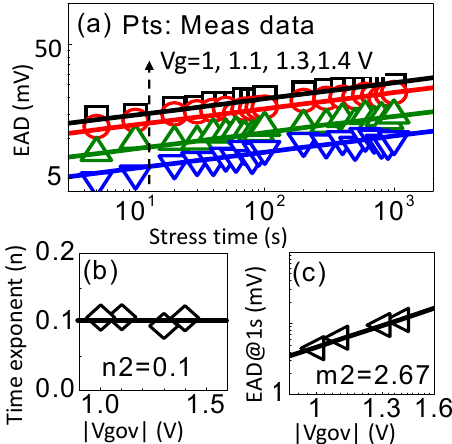
Figure 19. ( a ) The kinetics of an EAD follows the power law; ( b ) the time power exponent was insensitive to the stress bias; ( c ) an EAD also follows a power law against the stress overdrive voltage, Vgov [37].